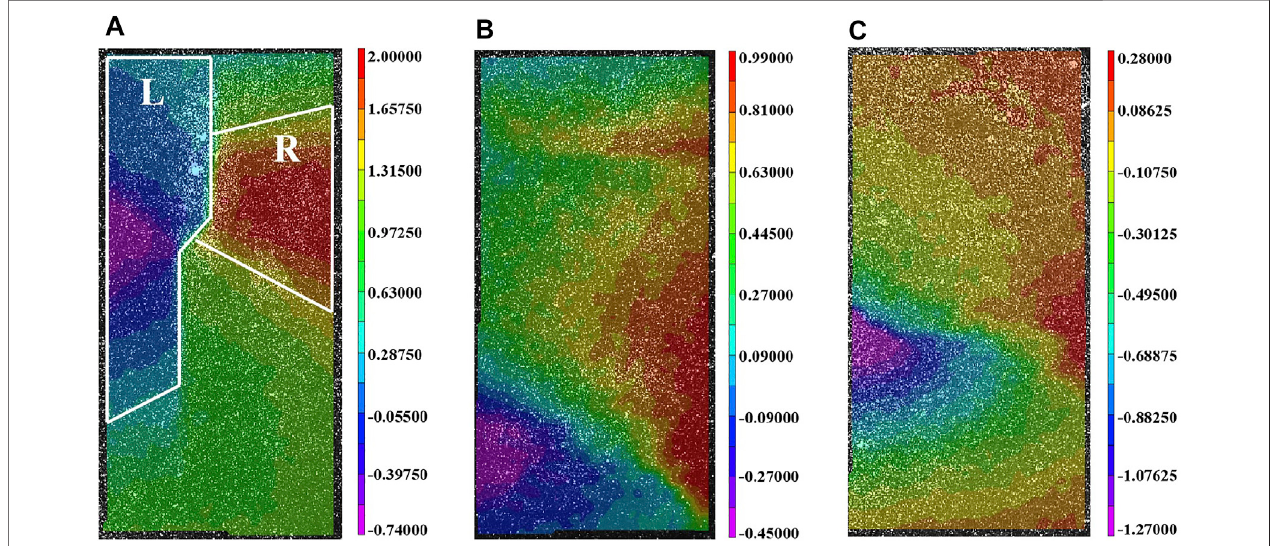
FIGURE 13 | Horizontal displacement fi eld of each specimen: (A) T-0.2, (B) T-0.3, and (C) T-0.4.